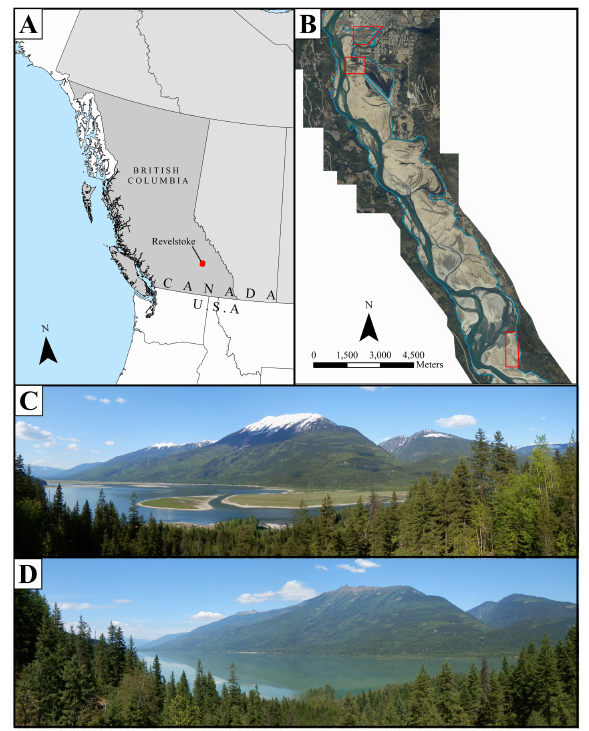
Fig. 1 . Maps and photos showing the location of Revelstoke in British Columbia (A), the three study plots (Illecillawaet, Machete Island, and Drimmie Creek) in relation to the Columbia River and the high-water mark for the Upper Arrow Lakes Reservoir (B), and a view of the Drimmie Creek study plot when water levels are low (C) and high